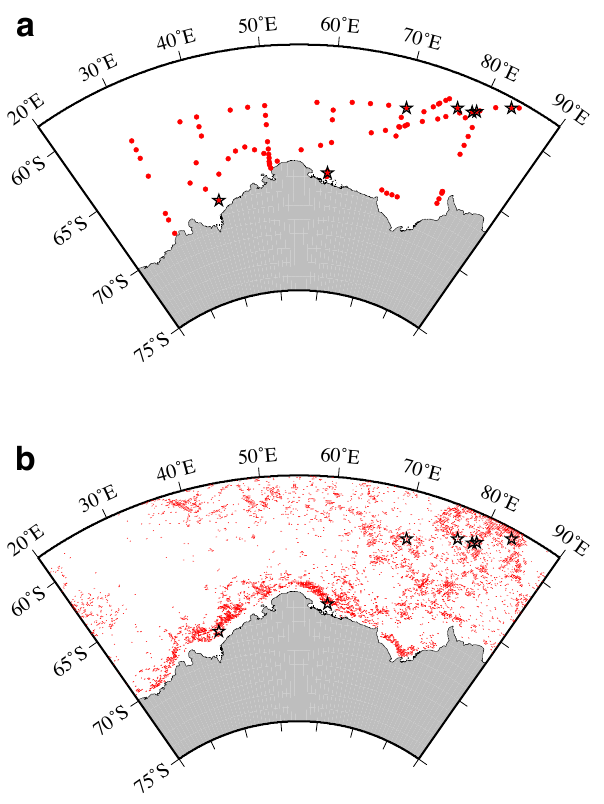
Fig. 4. Sites where diatoms were predominant during January– February 2006 as estimated by (a) CHEMTAX and (b) PHYSAT. Stars on the plots: Stations where both results were comparable to each other within ± 1 pixel and ± 2 days.